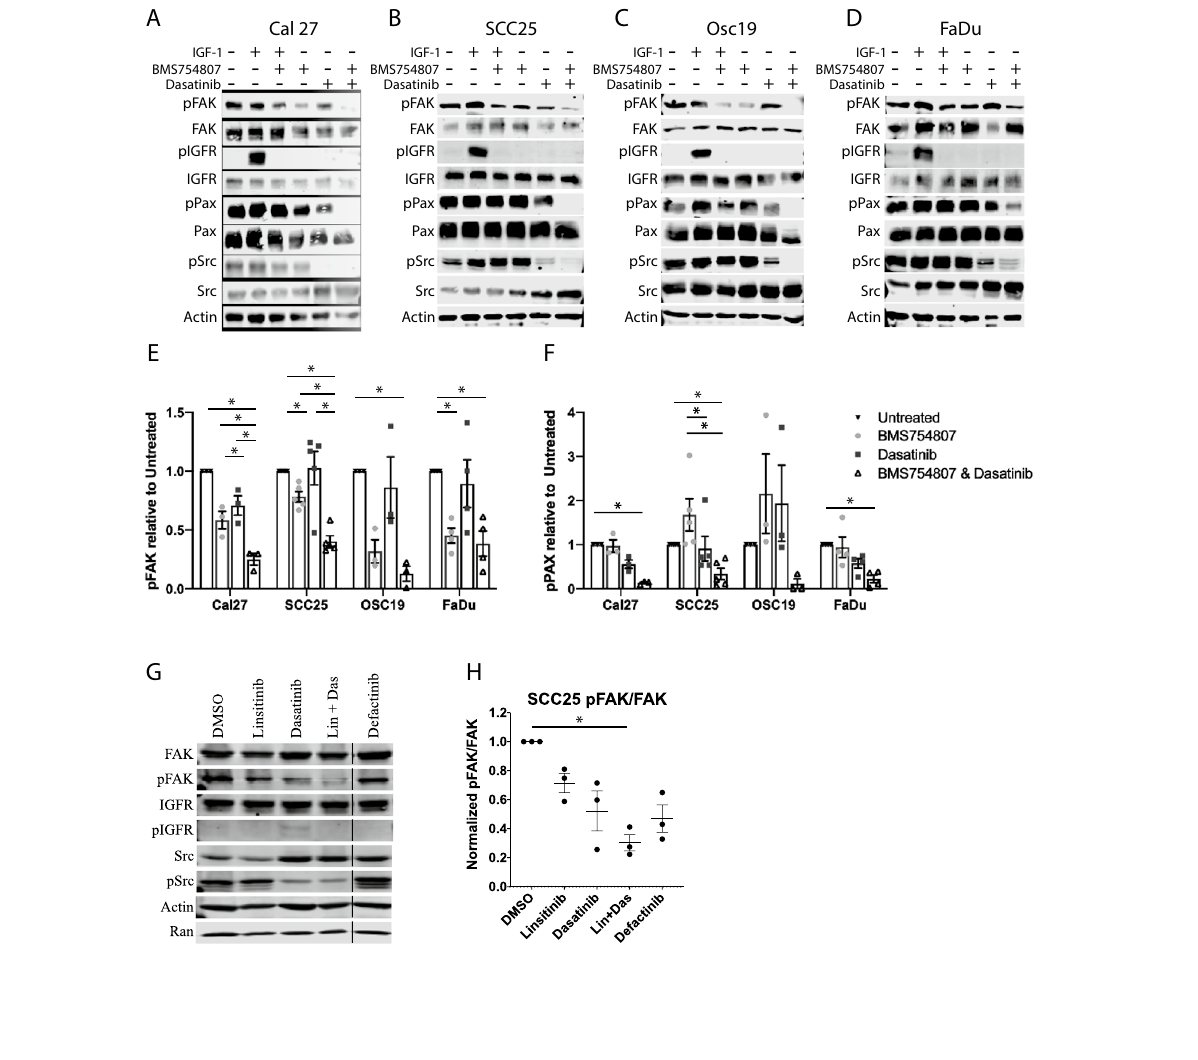
Figure 2. Treatment with BMS754807 and dasatinib alter focal adhesion signaling. Cal27 ( A ), SCC25 ( B ), OSC19 ( C ), FaDu ( D ) cells were treated with 1 µM BMS754807 ± 10 nM des(1–3)IGF-1, 25 nM dasatinib, or the combination of 1 µM BMS754807 and 25 nM dasatinib as indicated and immunoblot was performed. Representative blots from 3 to 5 independent experiments are shown. Each section of the membrane was probed independently for the respective labeled antibody and imaged independently when necessary to insure appropriate exposure. Each cell line was probed independently, cropping is delineated by white spacing between epitopes or black vertical line. Uncropped western blot images are shown in Supplemental Fig. 8. Changes in FAK Y397 ( E ) and paxillin Y118 ( F ) are quantified relative to untreated and represent the mean and SEM of 3–5 independent experiments. ( G ) SCC25 cells treated with 250 nM linsitinib or 25 nM dasatinib singly or in combination as in ( A – E ) and ( H ) quantified relative to untreated and represent the mean and SEM of 3 independent experiments. Asterisks represent p < 0.05 as determined by one-way ANOVA and Tukey post-hoc